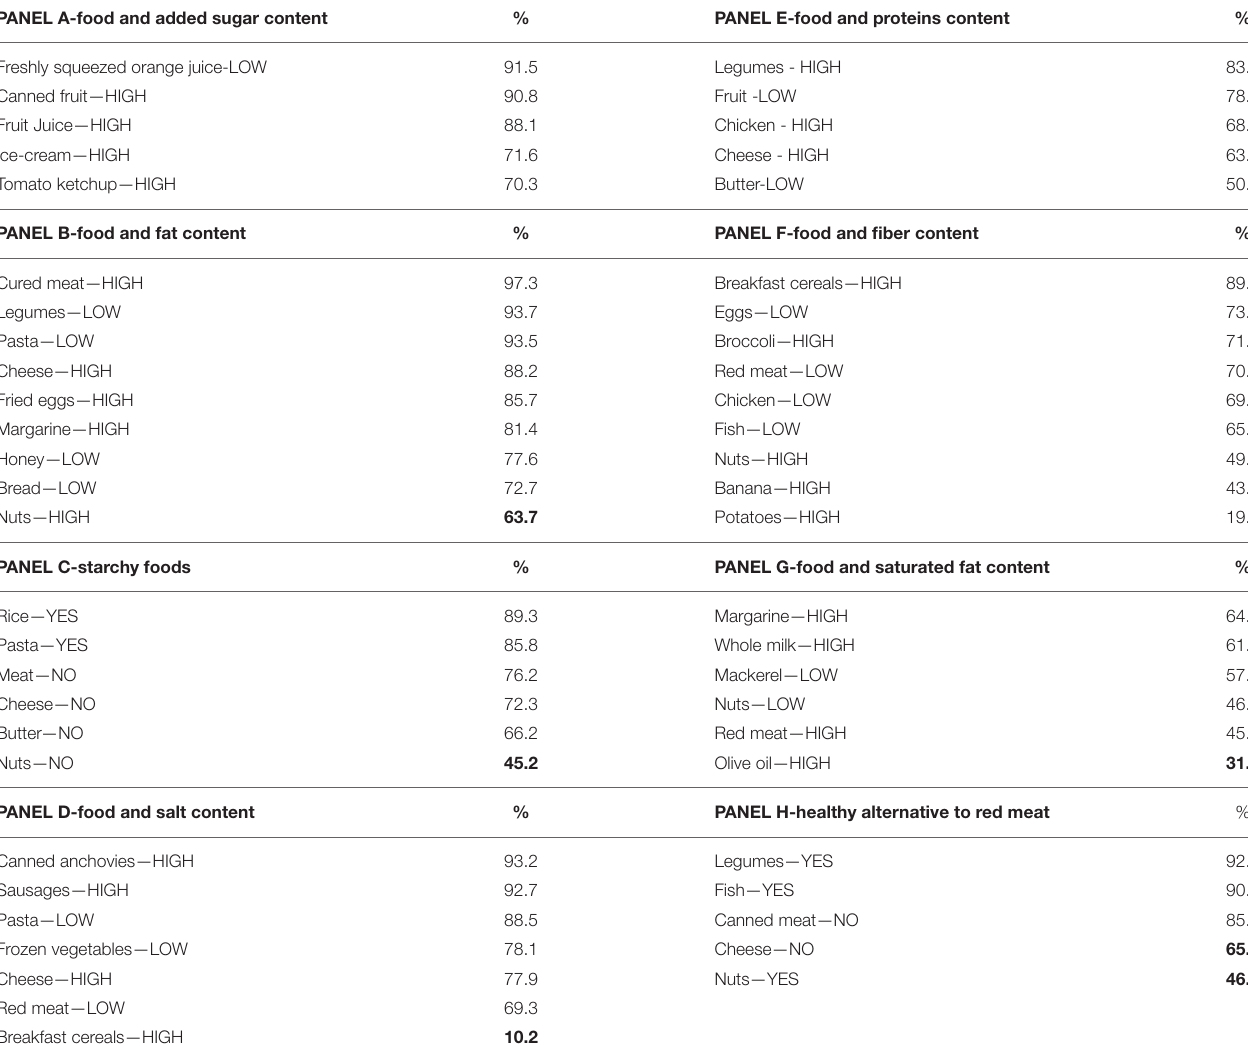
TABLE 3 | NK2 nutrient composition of food. PANEL A-food and added sugar content % PANEL E-food and proteins